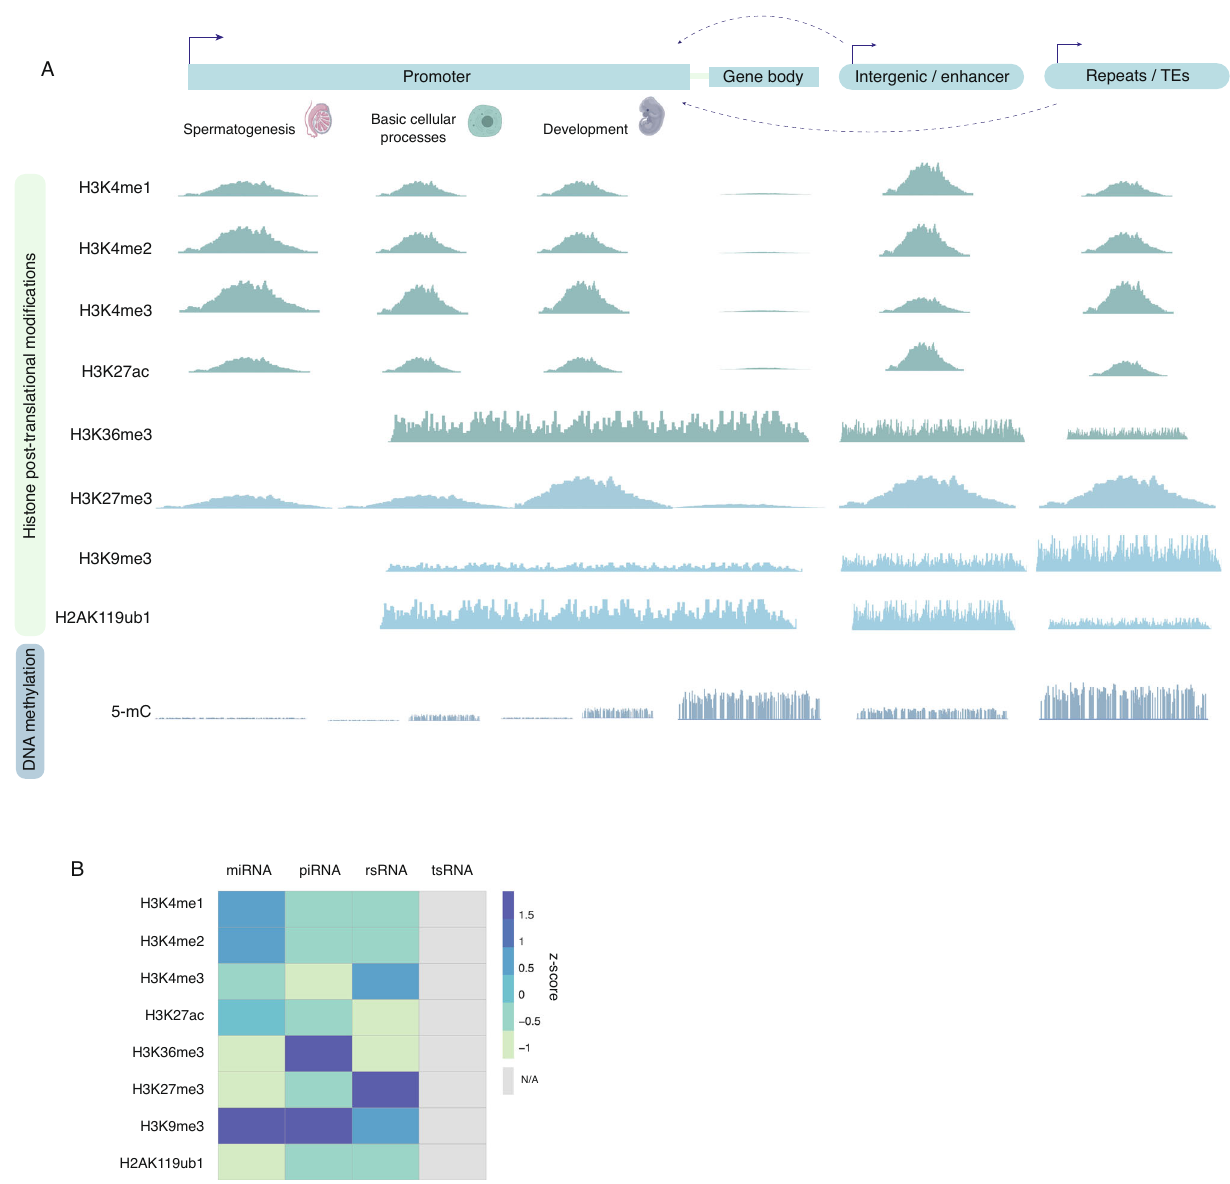
Fig.1|The fi nalcompositionofthespermepigenomepreparestheembryofor developmental competency. A A schematic showing the global epigenetic com- position of sperm relative to functional loci of interest from the perspective of sper- matogenesis and embryo development, based on whole-genome sequencing experiments 21,31,37,42 – 46,48,54,63,114,169 . For details on the dynamic nucleoprotein composi- tion through spermatogenesis refer to Box 1. Active and narrow marks in sperm including H3K4me1, H3K4me2, H3K4me3 and H3K27ac, are enriched at many promoters implicated in spermatogenesis, basic cellular processes, and develop- ment. Interestingly, these active marks are also enriched in intergenic space and putative enhancers. The enrichment of these marks relative to each other may in fl uence function. Other marks such as the active H3K36me3, and the repressive H3K9me3 and H2AK119ub1, broadly cover certain gene bodies, promoters, and intergenic space, including transposable elements. Finally, although over 70% of the sperm epigenome is in a methylated state, DNA methylation remains mostly